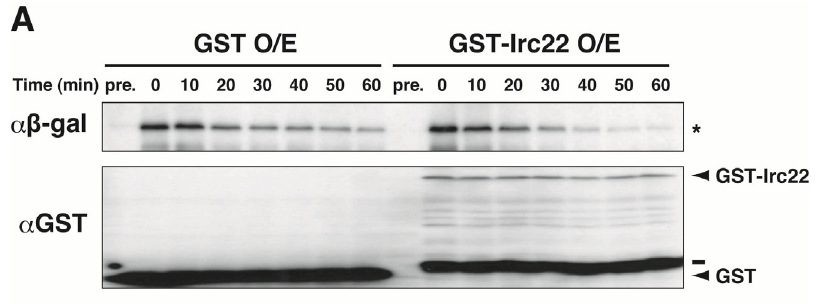
polyubiquitinated proteins in yeast cells. GST-Dsk2, GST-Rad23, GST-Ddi1,